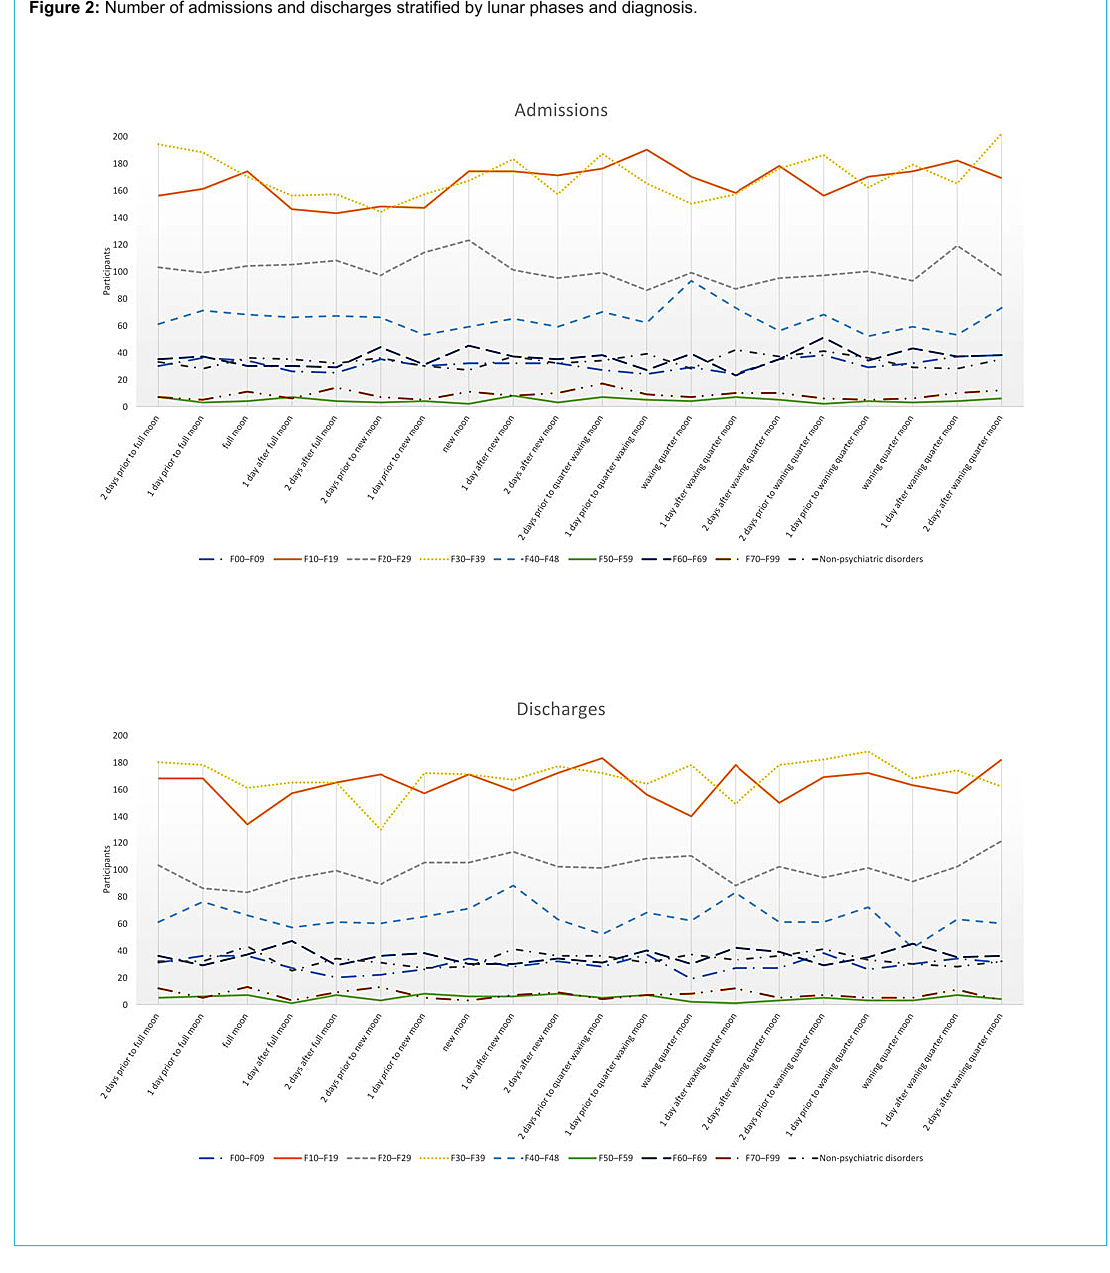
Figure 2: Number of admissions and discharges stratified by lunar phases and diagnosis.